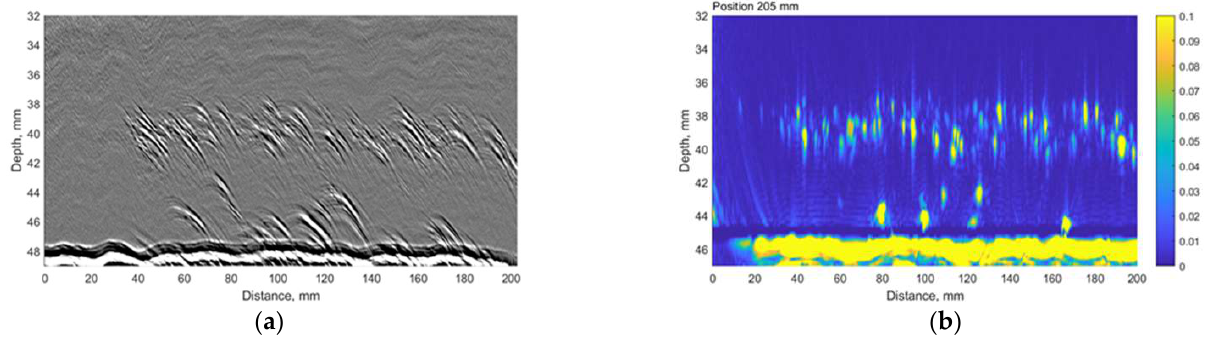
Figure 14. The comparison between ( a ) TULA and ( b ) TFM measurements at 205 mm circumferential scan position. Vertical colour bar represents the peak-to-peak amplitude in arbitrary units.